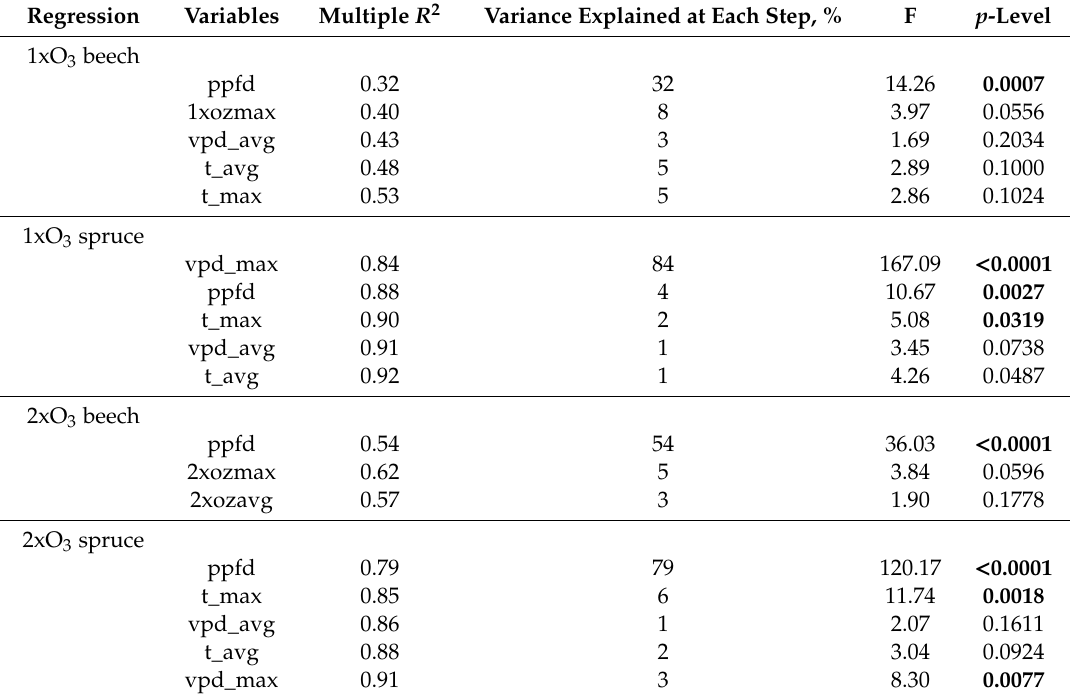
Table 2. Summary of a stepwise multiple linear regression to quantify the e ff ects of the daily 10-min means of O 3 concentrations (ozavg), O 3 peaks (ozmax), vapour pressure di ff erence means (vpd_avg),